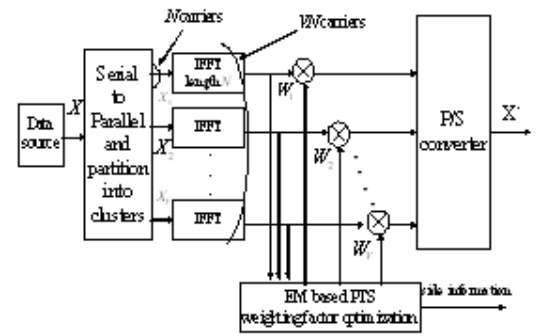
Fig. 1 A block diagram of the EM based PTS technique.